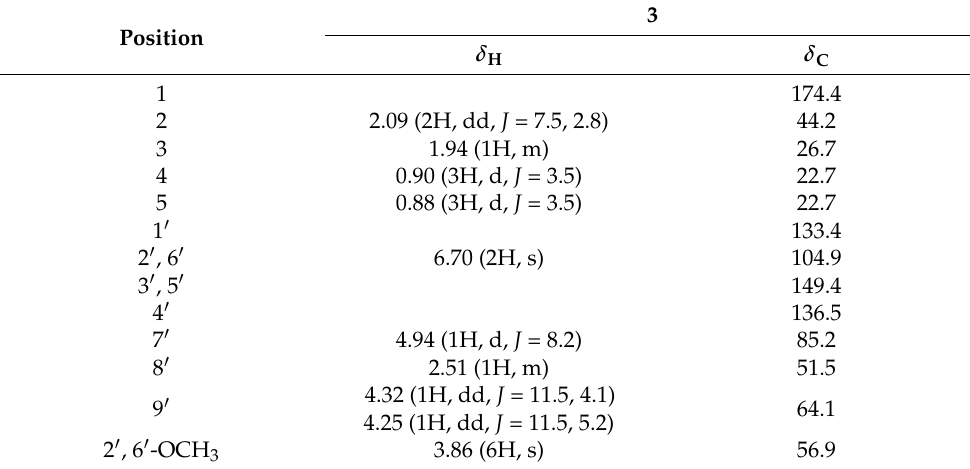
Table 3. 1 H NMR and 13 C NMR data of compound 3 ( δ in ppm, J in Hz) in CD 3